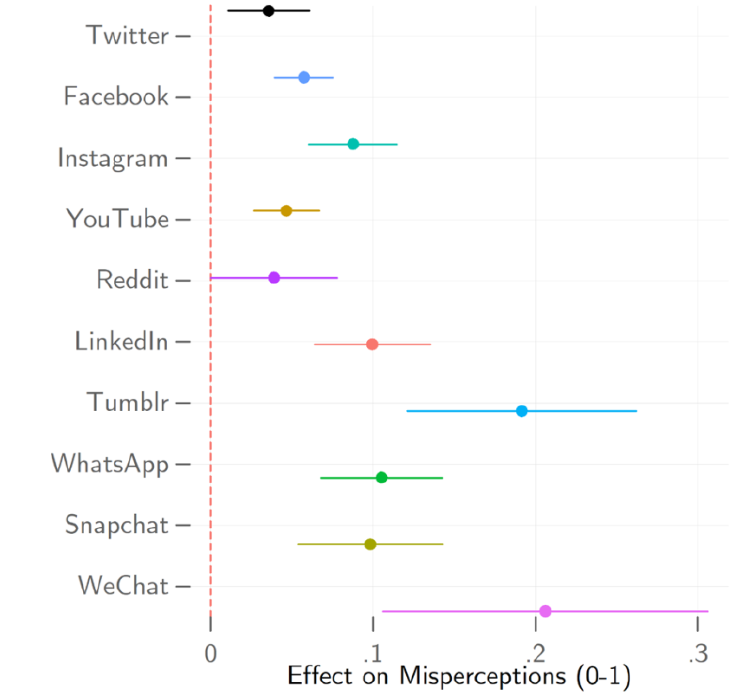
Supporting Figure 2. Estimated effects of social media application exposure on COVID-19 misperceptions. Note: controls for traditional news exposure, offline and online political discussion, income, education, age, gender, religiosity, language, and region. 95% confidence